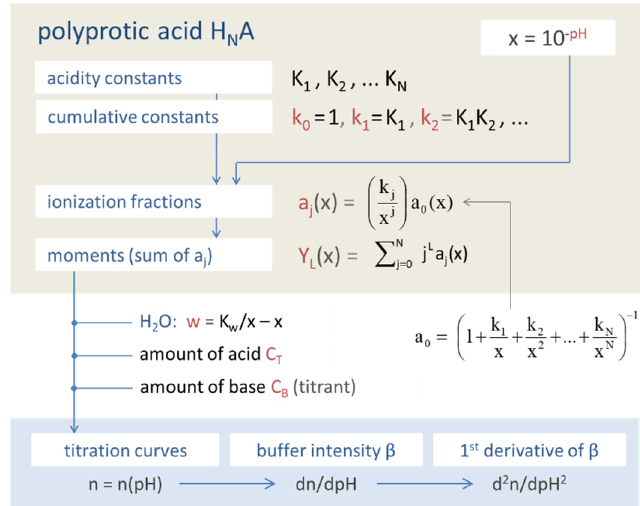
Figure 45. Building-block hierarchy of the acid–base model.